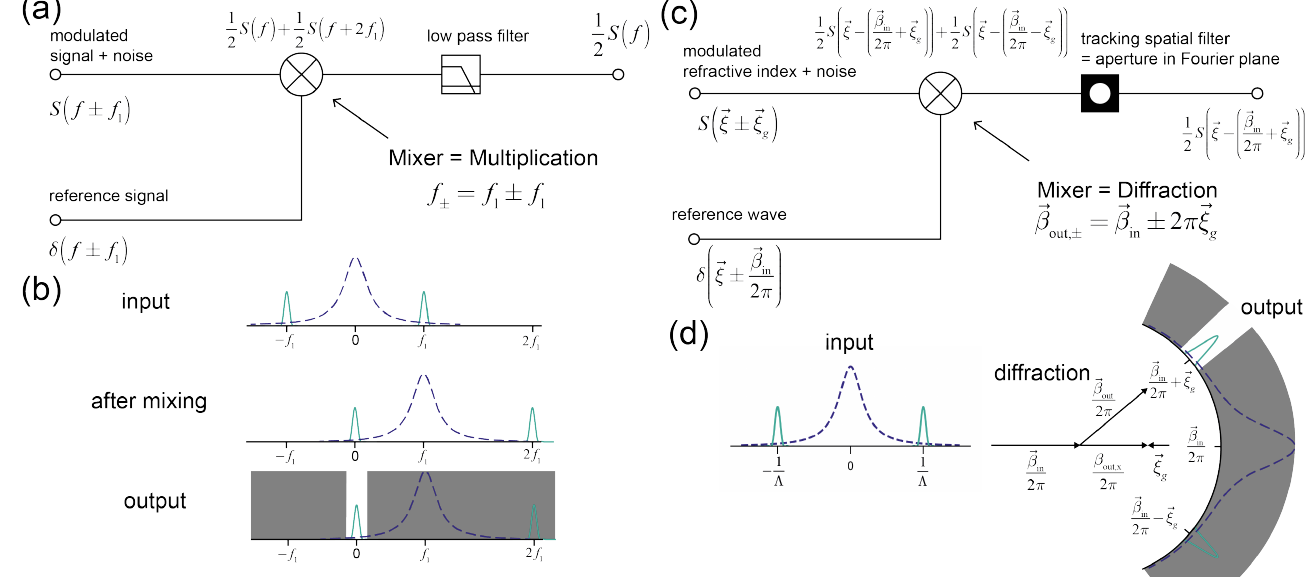
Figure 2. Analogies between a temporal ( a , b ) and a spatial lock-in ( c , d ) illustrated at simplified schematics a) The temporal lock-in uses a reference wave δ ( f ± f 1 ) from the same source as the signal (frequency f 1 ) that is mixed (multiplied) with the modulated and enveloped signal S ( f ± f 1 ) . This produces the sum and the difference of the two frequencies f 1 and locks one of the lobes of the signal to DC. A low-pass filter then isolates the DC component and produces an output that is proportional to the signal amplitude. ( b ) schematic depiction how the signal and the noise are shifted by the mixing and filtered by the low-pass filter. ( c ) In the spatial lock-in system a reference wave with momentum (cid:126) β in is mixed (diffracted) with the grating/crystal momentum of ordered matter (enveloped because of finite spatial extent S two diffracted waves (cid:126) β out . A spatial filter in a Fourier plane is then used to isolate one of these diffracted waves. ( d ) Schematic depiction how the modulated input and noise are mapped onto different angular directions by diffraction. The low frequency environmental noise is primarily scattered in the forward direction. A spatial filter isolates the signal component of